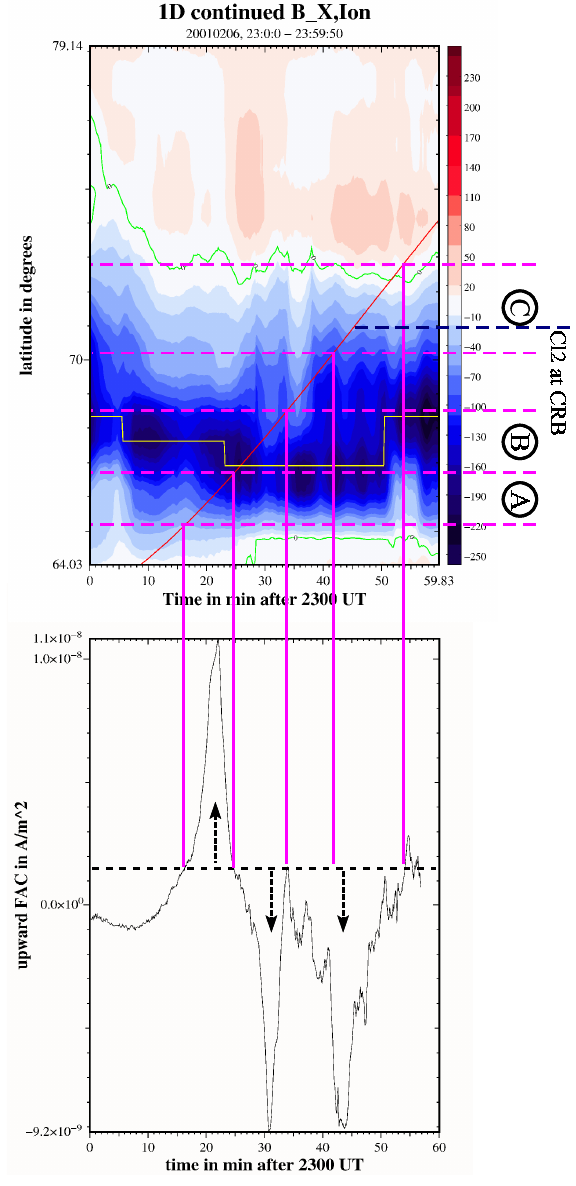
Fig. 13. (Upper panel) Magnetic field immediately below the iono- sphere along meridional profiles at the central meridian of MIRA- CLE, as derived from the ground magnetometers. Positive mag- netic fields correspond to eastward currents and negative ones to westward currents. The location of the change in sign is marked by a green line and called magnetic convection reversal boundary (MCRB). (lower panel) FAC measured by Cluster 2 with upward FAC being positive. The pink line marks the location of the mag- netic footprint of Cluster 2 in space and time, and the blue dashed line denotes the latitude at which the satellite crosses the CRB. (From Amm et al.,